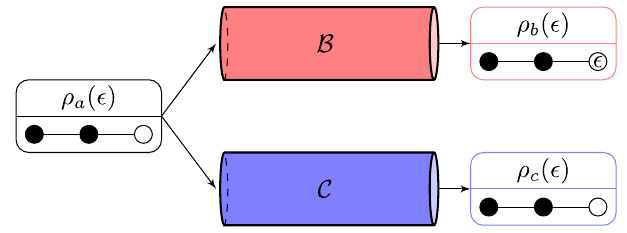
Fig. 2 Schematic for the reason behind an ϵ log-singularity. An input density operator ρ a ( ϵ ) is mapped by a channel B to a density operator ρ b ( ϵ ) and by the channel ’ s complement C to a different density operator ρ c ( ϵ ). Below each operator is a representation of its spectrum where closed and open circles indicate eigenvalues that, for all 0 ≤ ϵ ≤ 1, are nonzero and zero, respectively. A circle with ϵ indicates an eigenvalue that increases linearly from zero to leading order in ϵ . Since the spectrum of ρ b ( ϵ ) has a circle with ϵ , its von-Neumann entropy has an